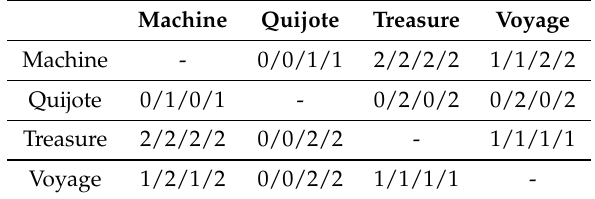
Table 22. Test results for dissimilar Word files with SiSe (hash vs. hash/file vs. hash/hash vs. file/file vs. file).